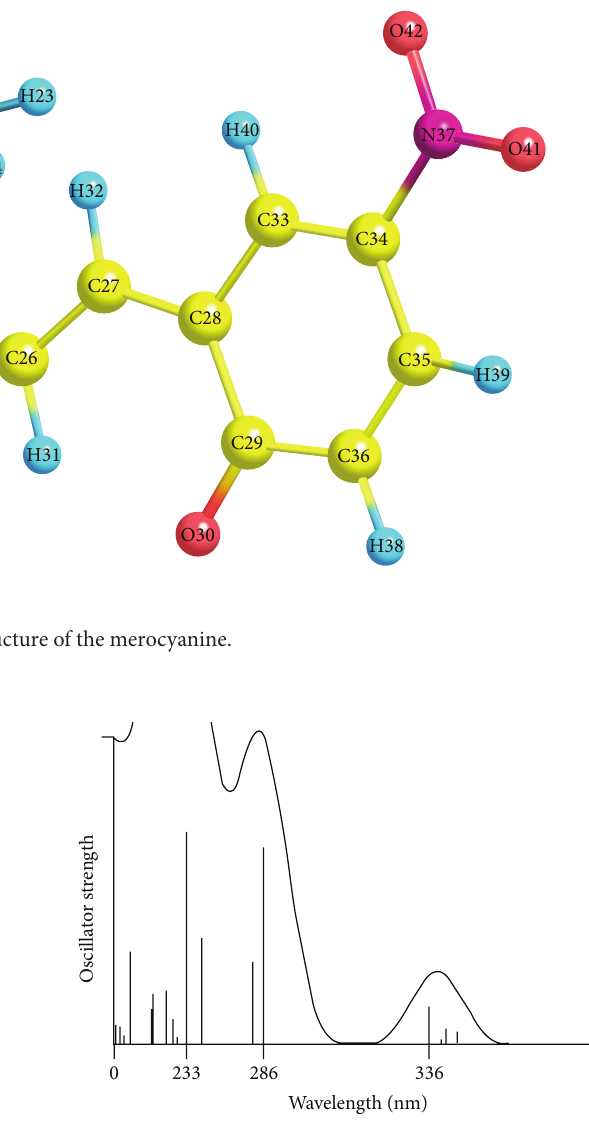
Figure 3: The absorption spectrum of the